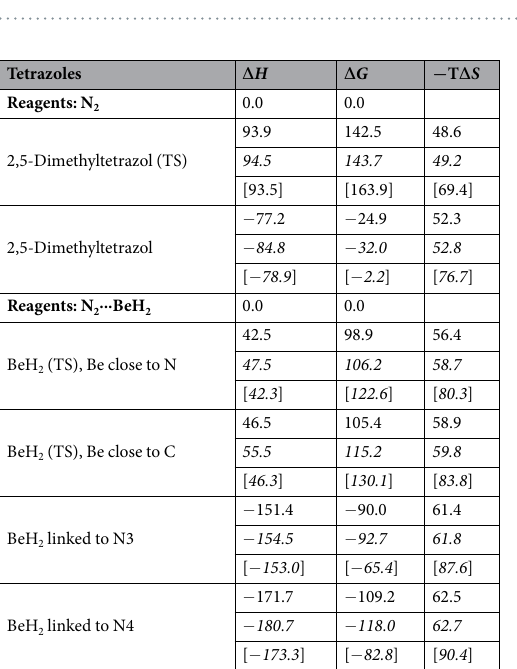
Figure 7. Energy profile for the reagents, transition state and products for the H 2 Be···N 2 + H 3 CNNCCH 3 reaction at the B3LYP/6-31 G(2fd,p) level of theory. The relationship between distortion energy, interaction energy and the barrier is also shown in the picture.